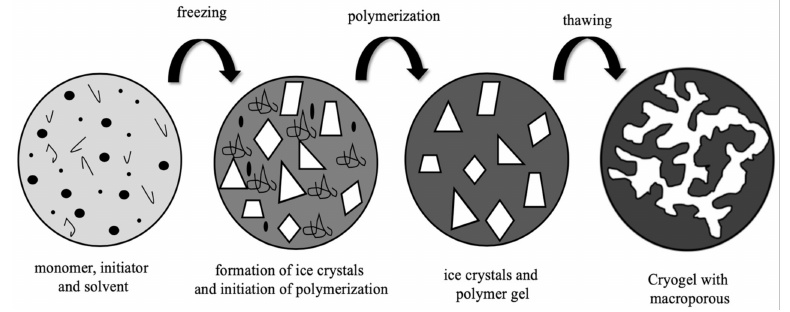
Figure 1. Illustration of supermacroporous cryogel